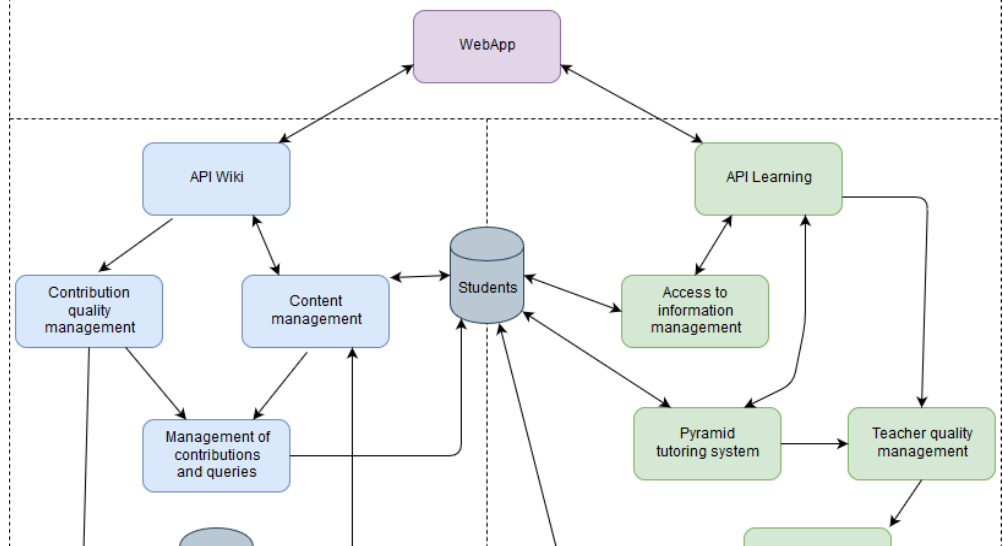
Figure 2. Organizational diagram